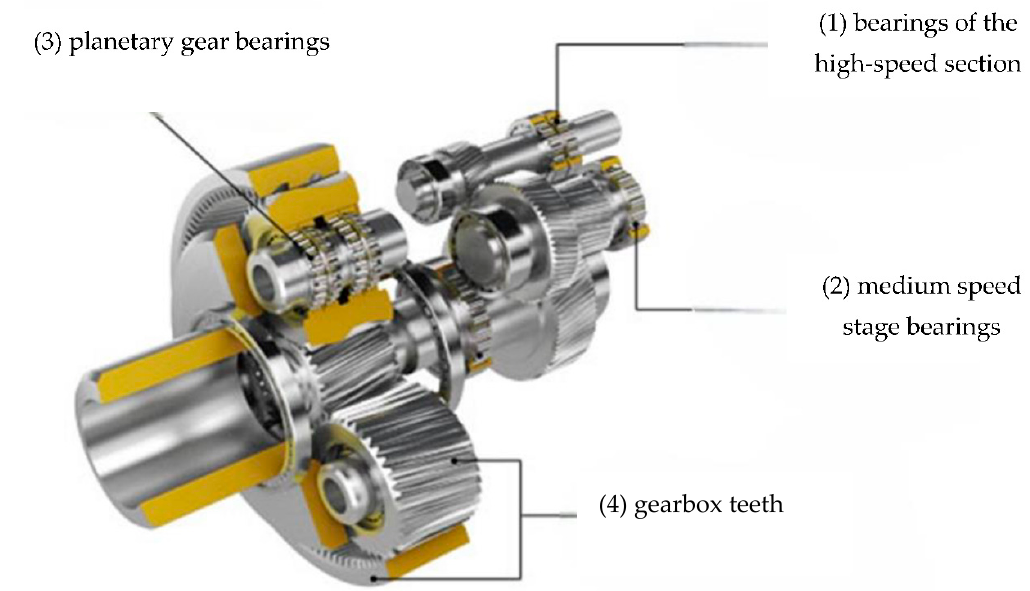
Figure 2. The planetary gear of the wind turbine (1—bearings of the high-speed section; 2—medium speed stage bearings; 3—planetary gear bearings; 4—gearbox teeth) (with permission of Olympus) [19].